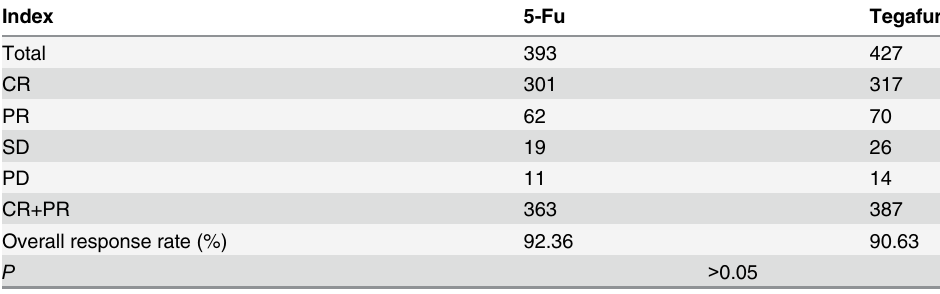
Table 3. Comparison of therapeutic effect between the tegafur and 5-Fu groups.